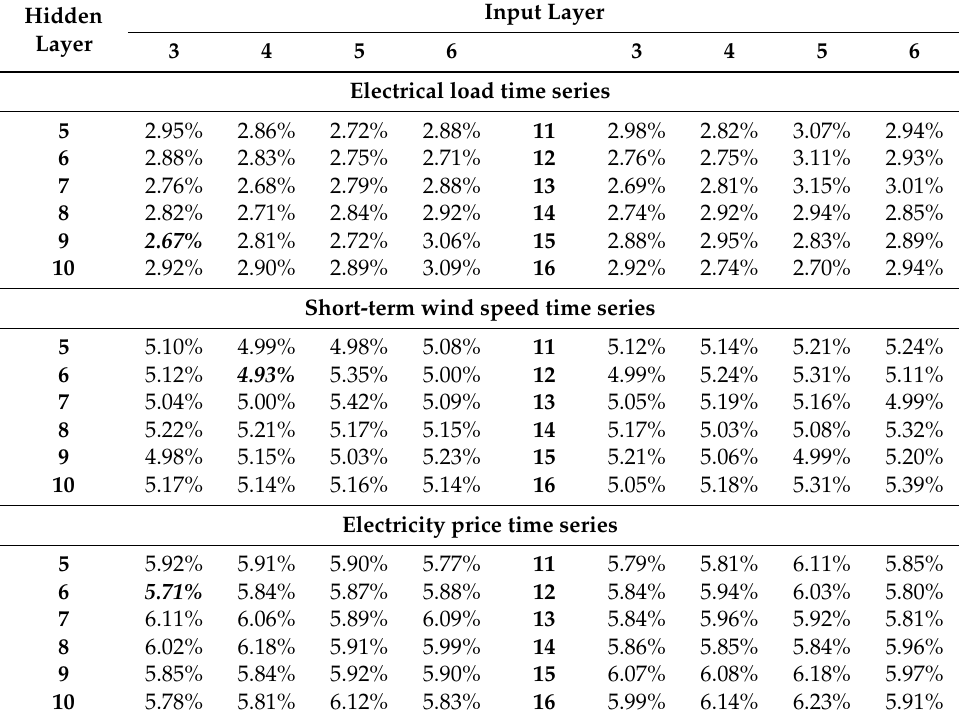
Table 7. Selection of input layers and hidden layers of BP neural network